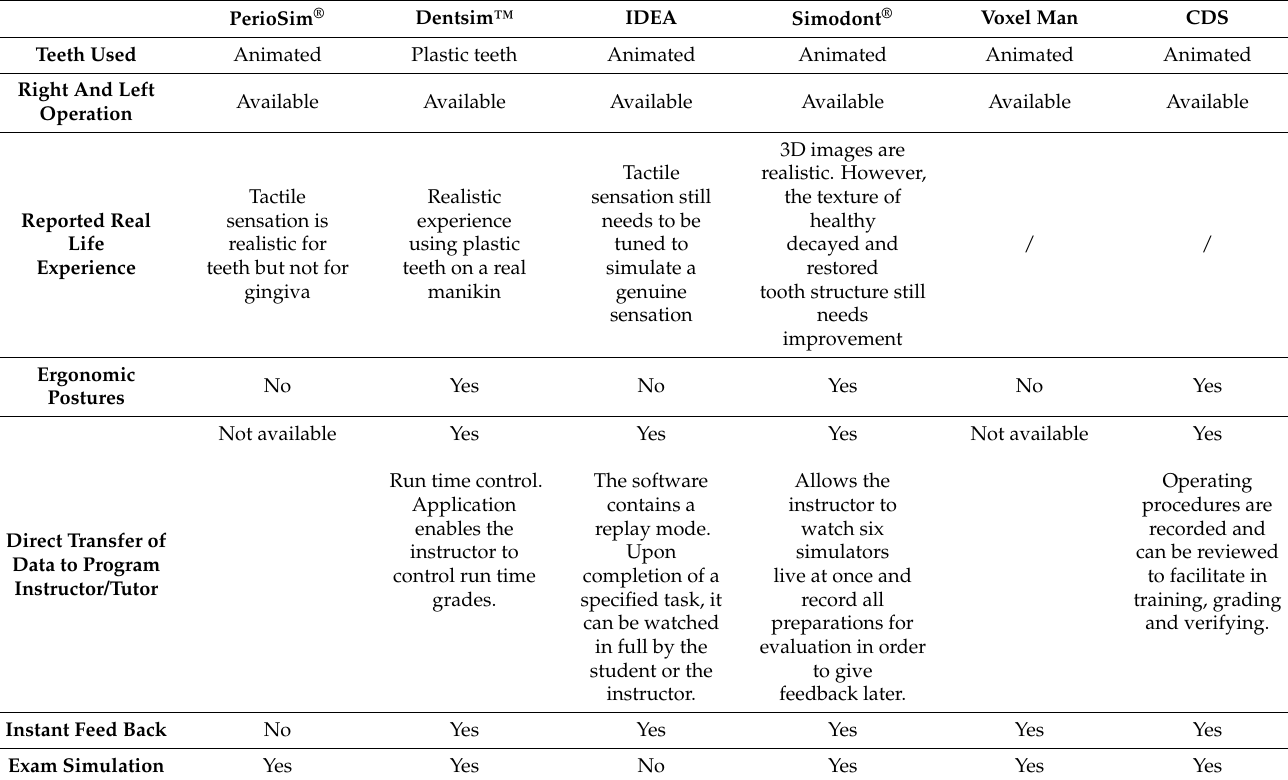
Table 2. Comparison of different dental